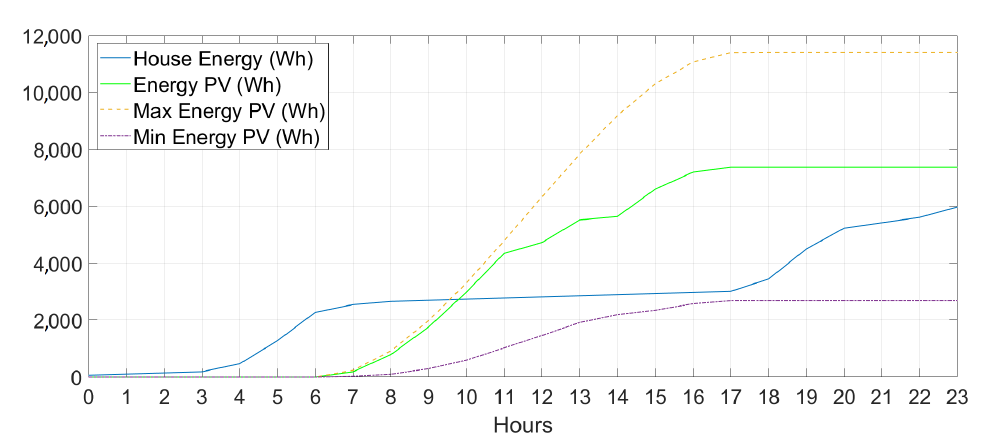
Figure 19. Profile 1 vs. 2 kW system (day).